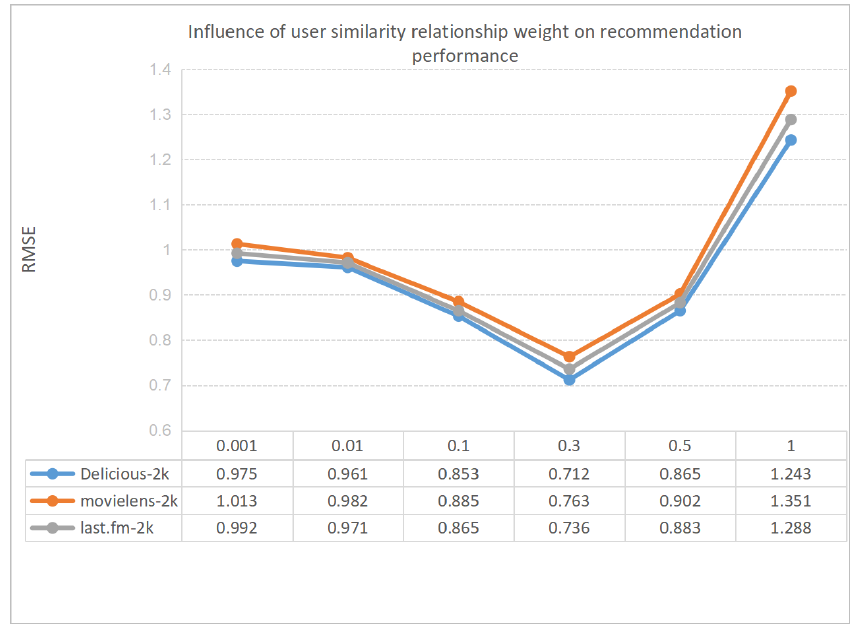
Figure 8. Influence of user similarity relationship weight λ S on recommendation